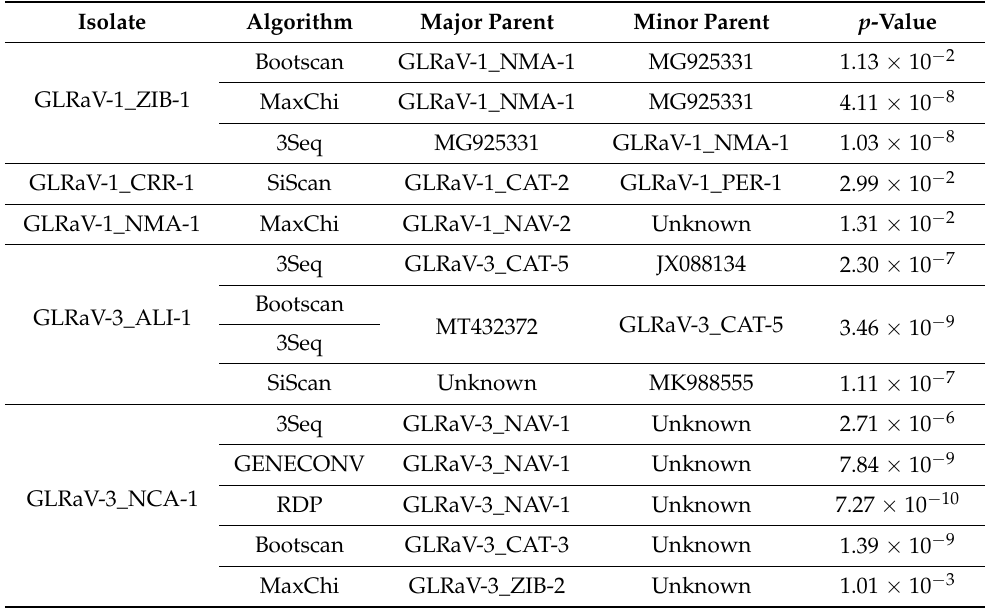
Table 6. Candidate and putative recombinant events detected on Sicilian GLRaV-1 and GLRaV- 3